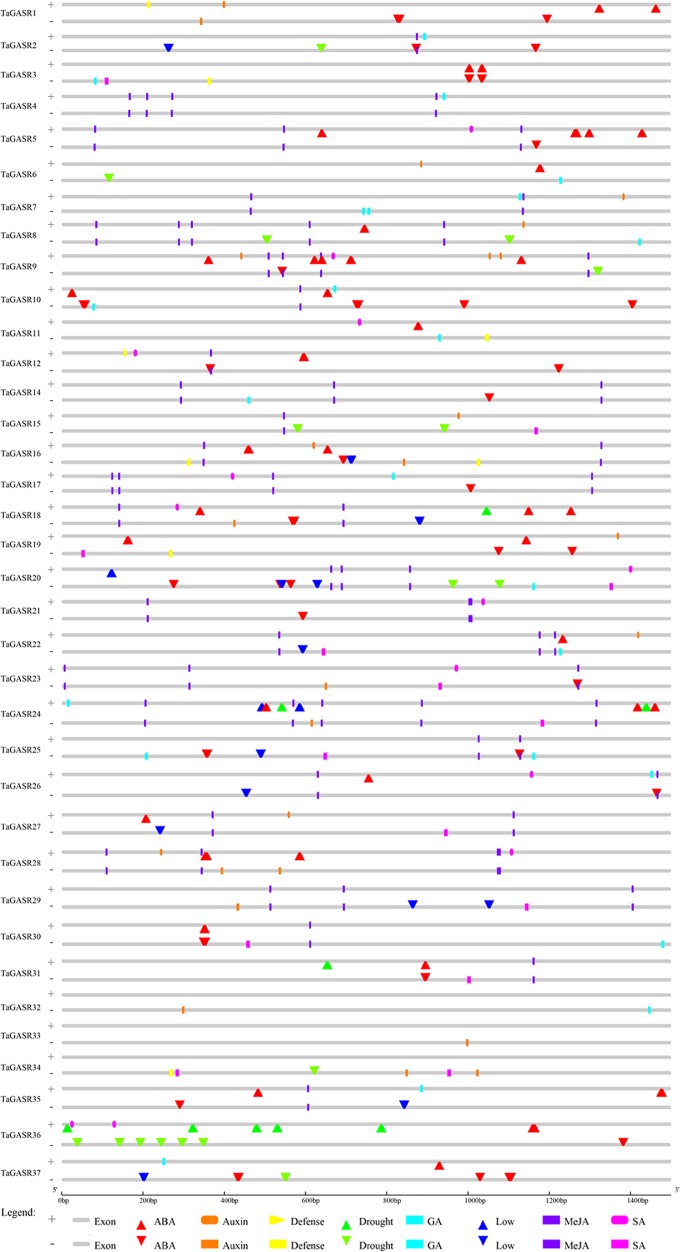
Cis-acting element analysis of the promoter regions of TaGASR genes. Based on functional annotation data, cis-acting elements were classified into two major classes: phytohormone responsive elements (i.e. those responsive to ABA, auxin, GA, MeJA, and/or SA) and abiotic stress response cis-acting elements (e.g. those involved in plant defense, drought stress response, and/or low temperature stress response).